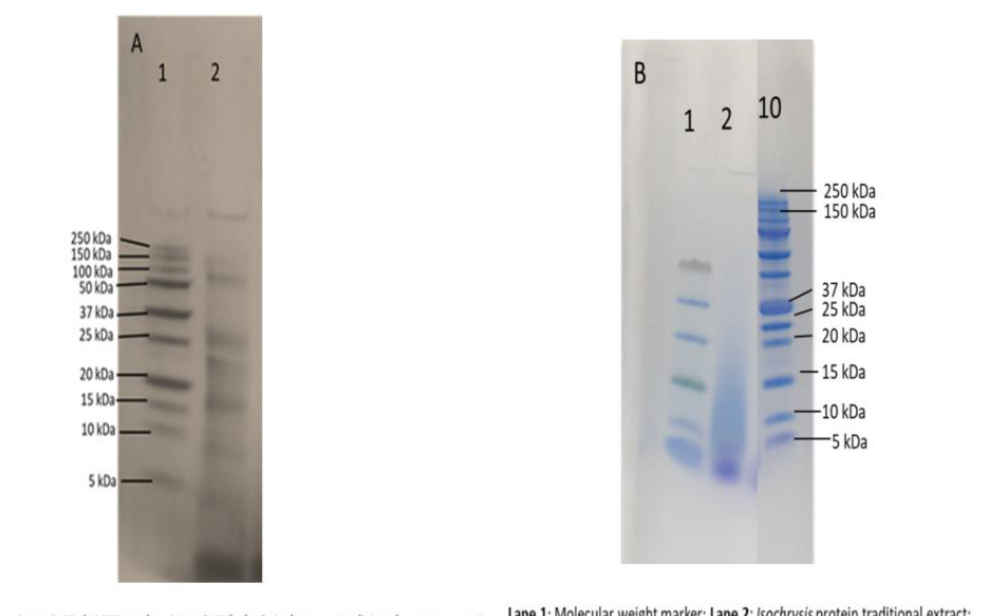
Figure 3. Tris-Tricine SDS-PAGE, performed using a Mini-PROTEAN ® electrophoresis unit using Mini-PROTEAN ® 10–20% Tris-Tricine precast gels (Bio-Rad laboratories, USA) for Spirulina sp. protein extract ( A ) and Isochrysis sp. protein extract ( B ).